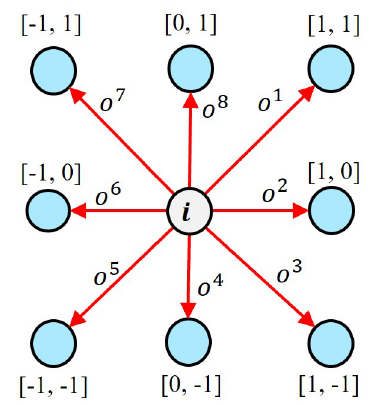
Figure 3. Adaptive adjustment of the keypoint. For local features, we use a simple convolutional network to predict the offset map, which contains offsets on eight orientations. Different prediction weights are weighted to the offset maps separately, and the keypoint is dynamically adjusted by the weighted offset values. The keypoint location information is refined at the